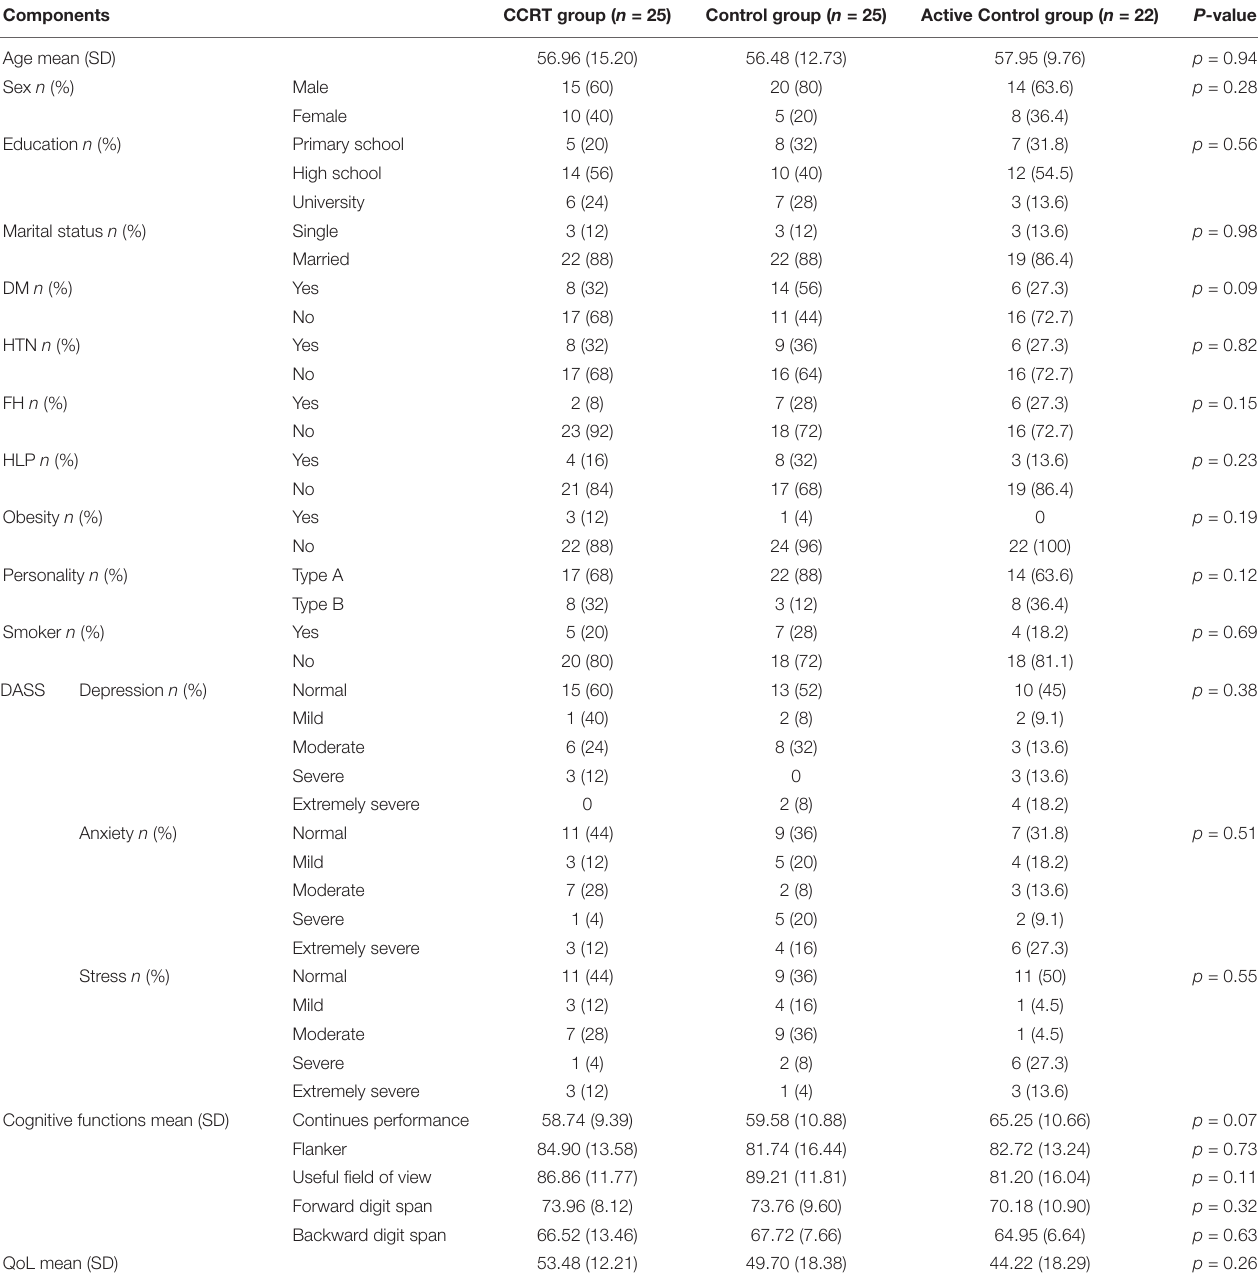
TABLE 1 | Demographics, clinical variables and baseline scores of cognitive measures and QoL questionnaire in CCRT, control and active control groups.